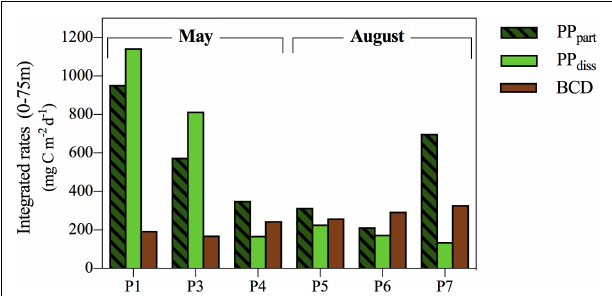
FIGURE 5 | Integrated (0–75 m) rates of phototrophic particulate (PP part ) and dissolved primary production (PP diss ), as well as the daily bacterial carbon demand (BCD) calculated from bacterial